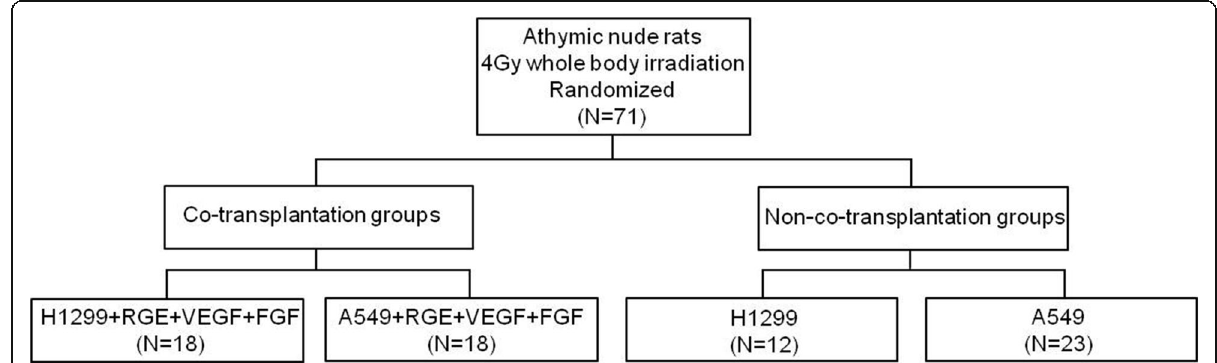
Fig. 1 Experimental Groups. Survey of the four experimental groups with the different compounds of the subcutaneously injected cell suspensions. Two different tumor cell lines (H1299 and A549) and co-transplanted vascular growth promoters ( RGE rat glomerular endothelial cells, VEGF vascular endothelial growth factor, FGF fibroblast growth factor)